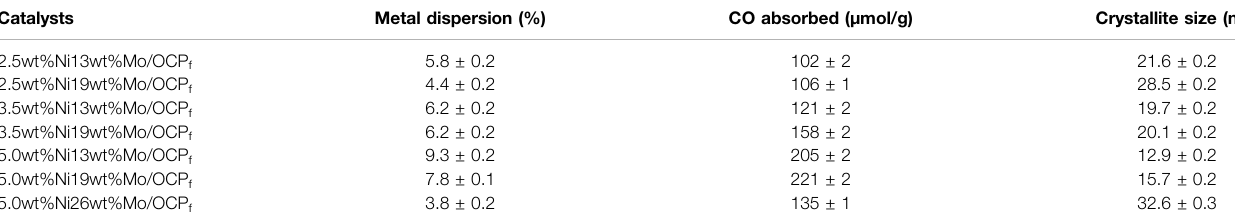
TABLE 2 | CO-chemisorption analysis of all the OCP f -supported NiMo catalysts. Catalysts Metal dispersion (%) CO absorbed (µmol/g) Crystallite size